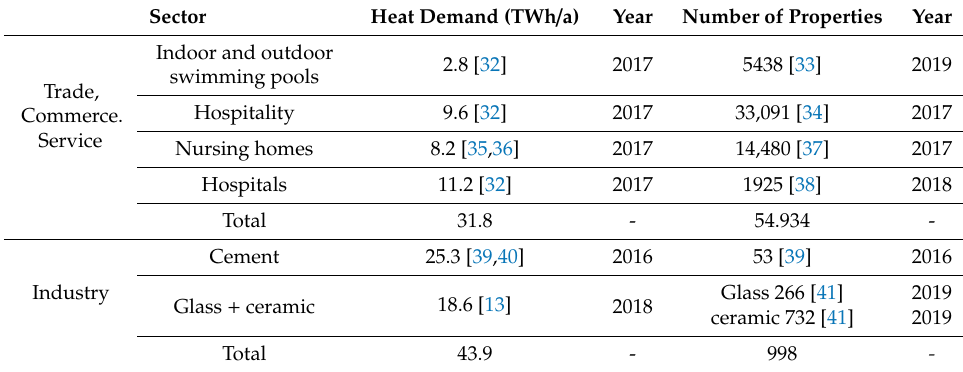
Table 1. Heat demand for the most promising branches, projections for 2016 / 2019 in TWh / year. Detailed information about the results of the in-depth market analysis and best practice models can be found in [30,31].